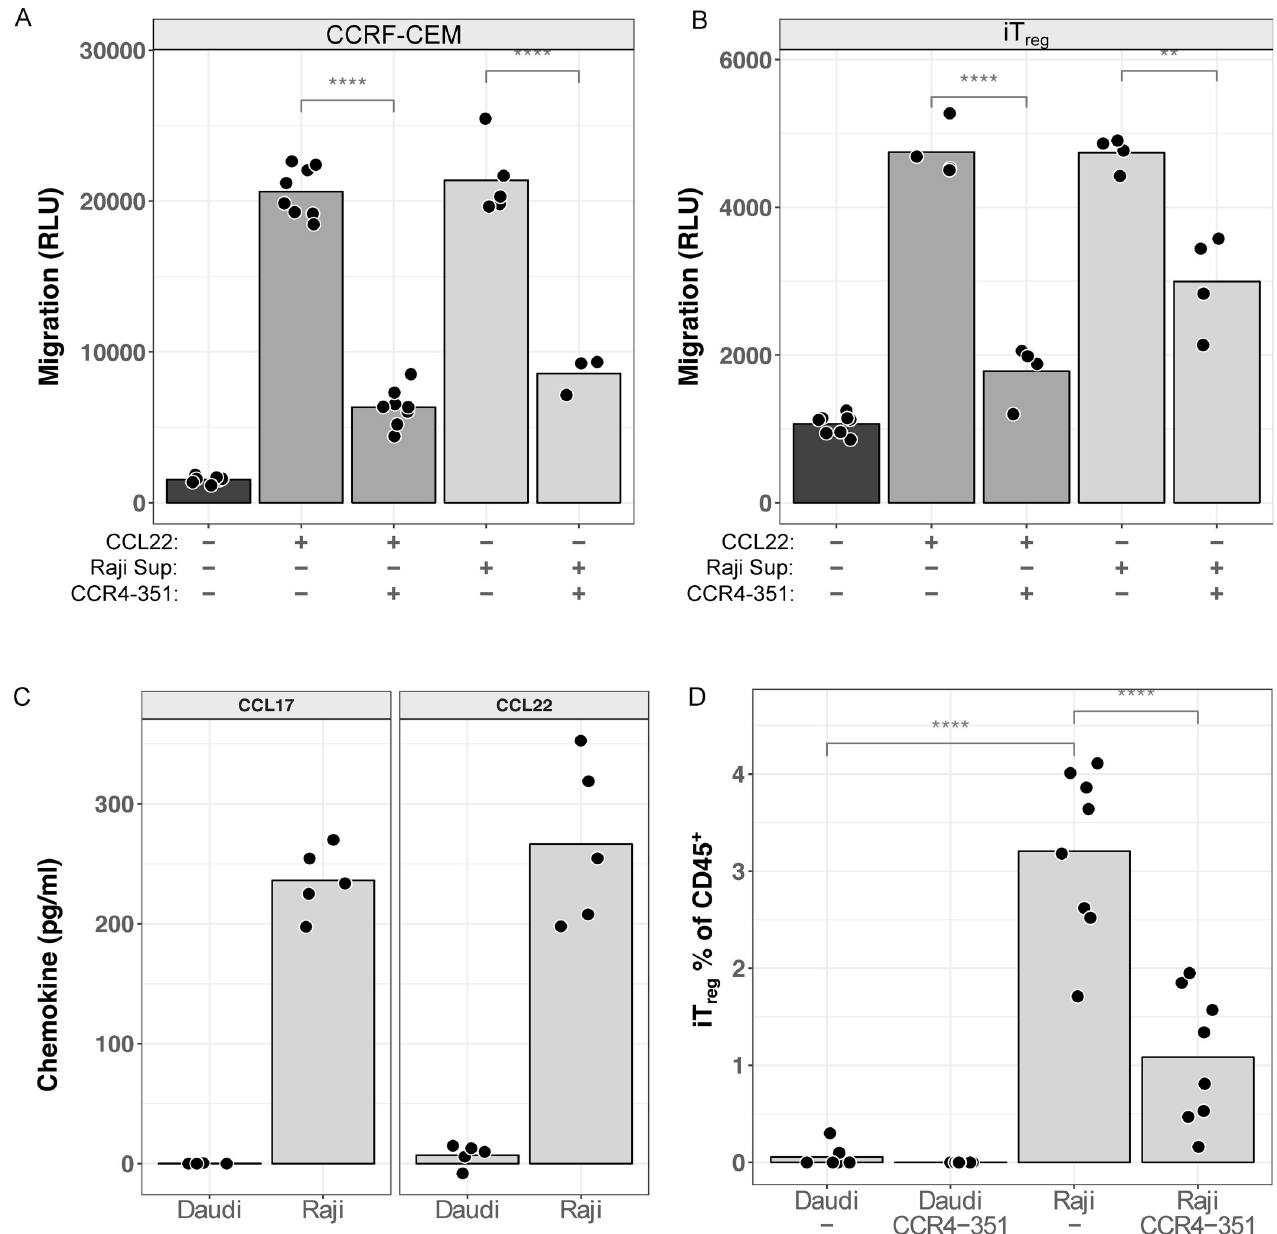
Fig 2. CCRF-CEM and T reg migrate towards Raji in a CCR4-dependent manner. (A) Chemotaxis assays were performed on CCRF-CEM cells towards recombinant CCL22 or Raji cell supernatant with or without the CCR4 antagonist CCR4-351. Relative luciferase units (RLU) are shown as a proxy for migrated cell number. (B) Migration assays were performed with human iT reg . (C) Raji and Daudi xenograft tumors grown in NOD/SCID mice (n = 5) were assayed for chemokine levels by ELISA. (D) Human iT reg were transferred into Daudi or Raji tumor-bearing mice (n = 8) and allowed to migrate for 5 days, followed by harvesting of the tumors. Mice were treated with vehicle or CCR4-351. Fractions of human CD45 + cells which were iT reg (identified as CD45 + CD4 + CD19 - ) were quantitated by